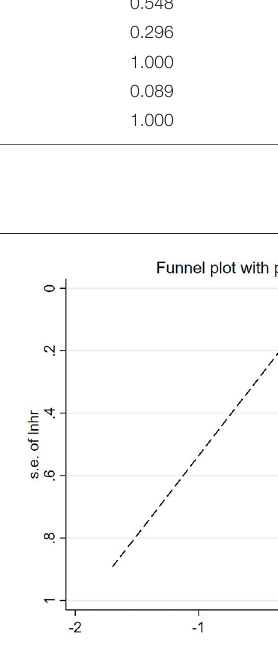
FIGURE 6 | Funnel plot of the association between serum uric acid levels (low vs. middle) and all-cause mortality in PD